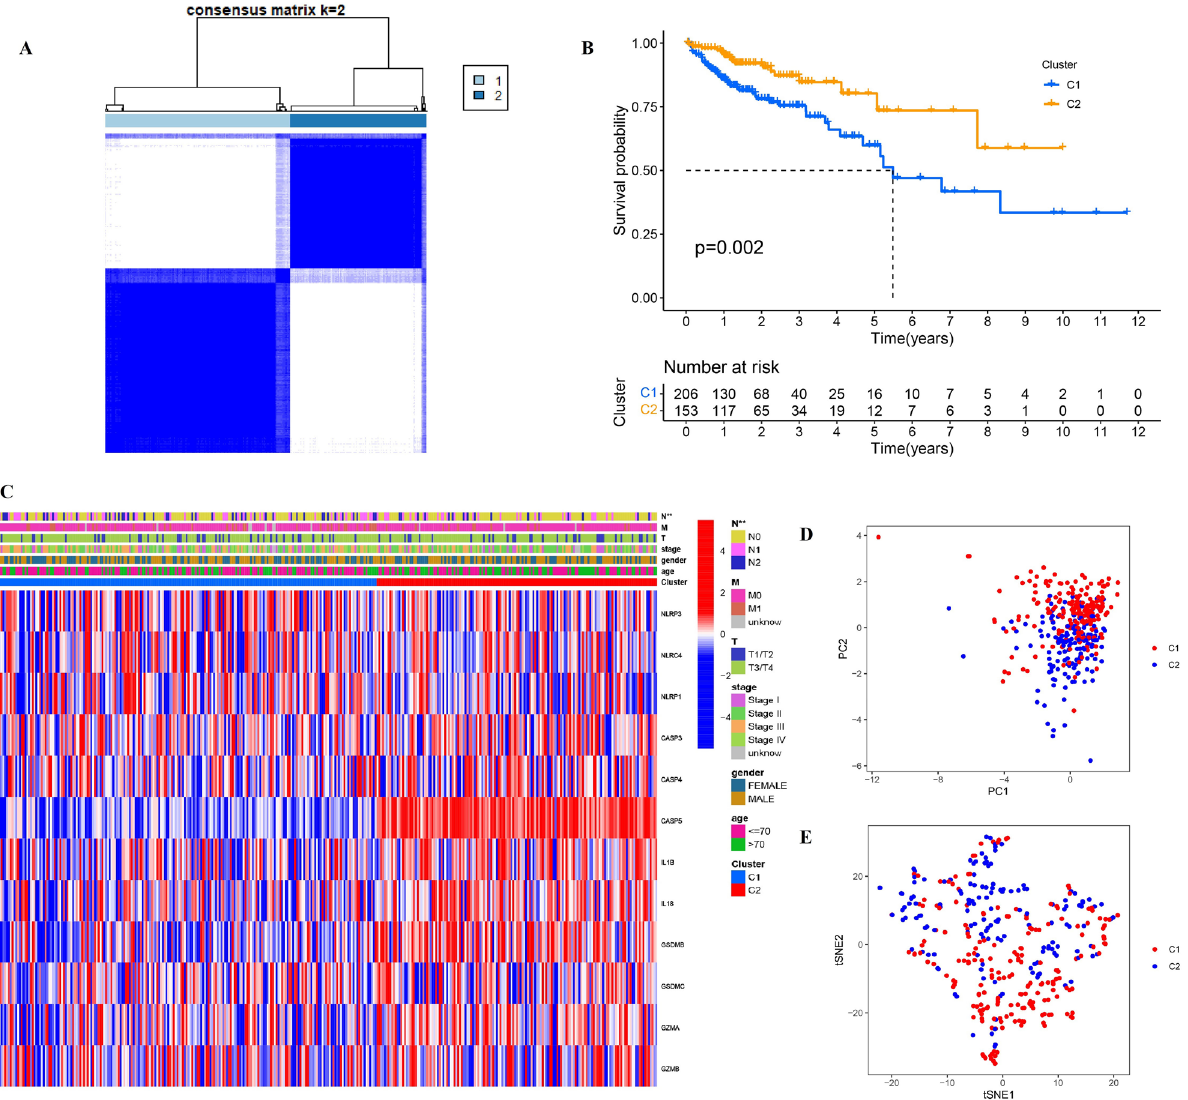
Figure 3. Classification patterns mediated by 12 differentiated pyroptosis-related genes. ( A ) Two different regulation patterns were constructed by using unsupervised clustering method; ( B ) survival difference between clusters; ( C ) clinicopathological characteristics of two clusters. ( D ) and ( E ) PCA analysis for two